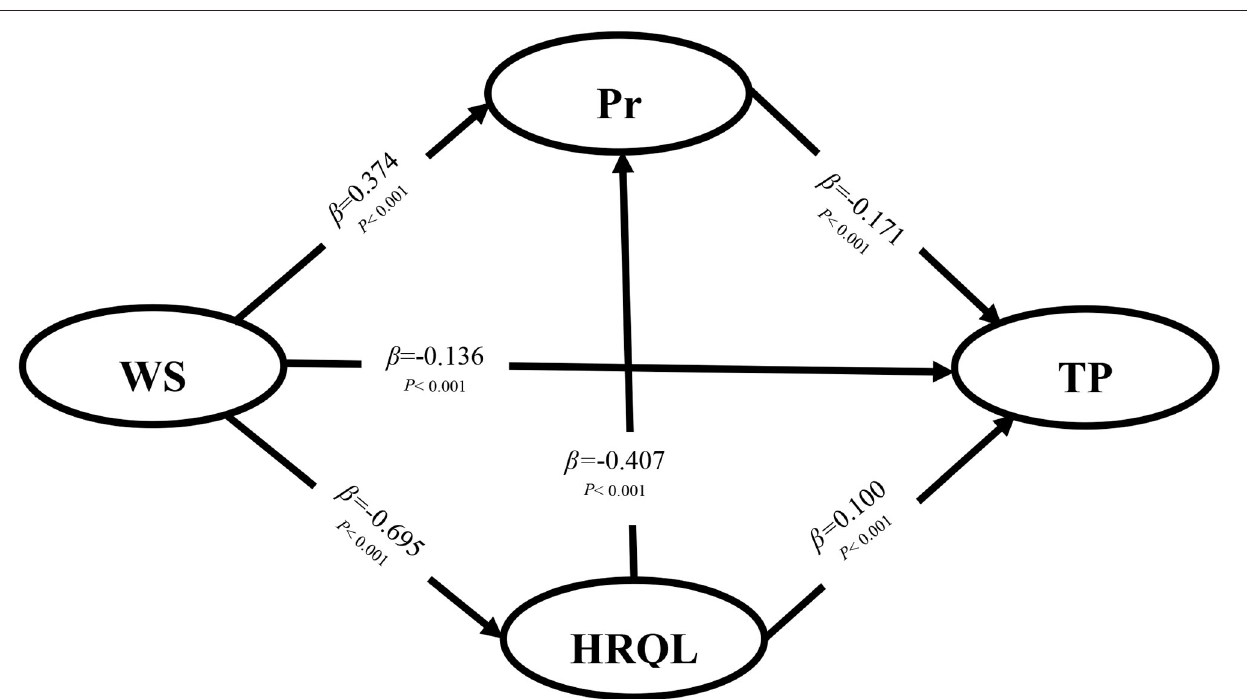
FIGURE 2 | The results of hypothesis testing. TP, task performance; WS, work stress; HRQL, health-related quality of life; Pr,